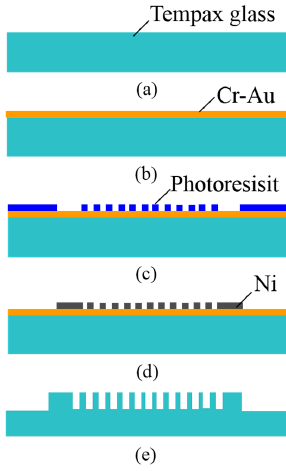
Figure 6. Fabrication process. ( a ) Tempax glass wafer; ( b ) Cr-Au sputtering; ( c ) immersion photolithography; ( d ) nickel electroplating; ( e ) RIE process.